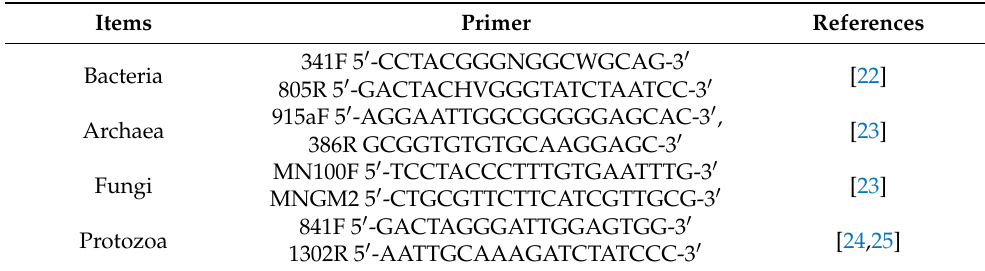
Table 2. Primers for rumen microbial